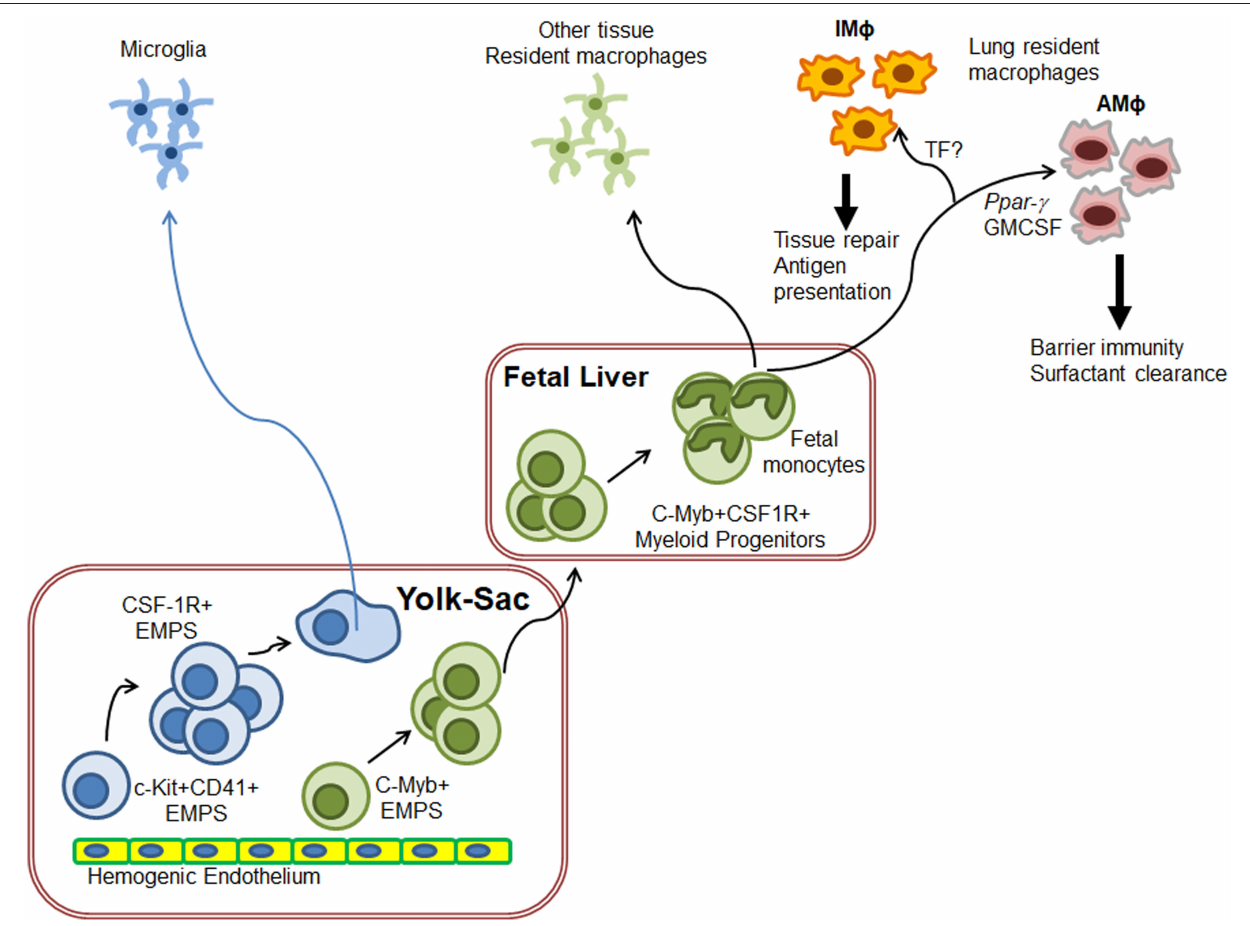
FIGURE 1 | Schematics of generation of lung resident macrophages. Based on the ontogeny of tissue resident macrophages (TRM), microglia originate directly from yolk-sac (YS) macrophages while other TRM originate from fetal liver monocytes. In the case of lungs, F4/80 + embryonic YS-M 8 seed the budding lung around E10.5 as primitive IM 8 . On E12, fetal liver monocytes enter the alveoli after birth and differentiate into AM 8 to regulate lung surfactant generation and host response F4/80 + bone marrow M 8 also arrive at the lung on E16 where they expand to form “definitive” IM 8 . IM 8 role needs to be defined but these are predicted to induce wound repair. Exact molecular control of IM 8 generation has not yet been fully